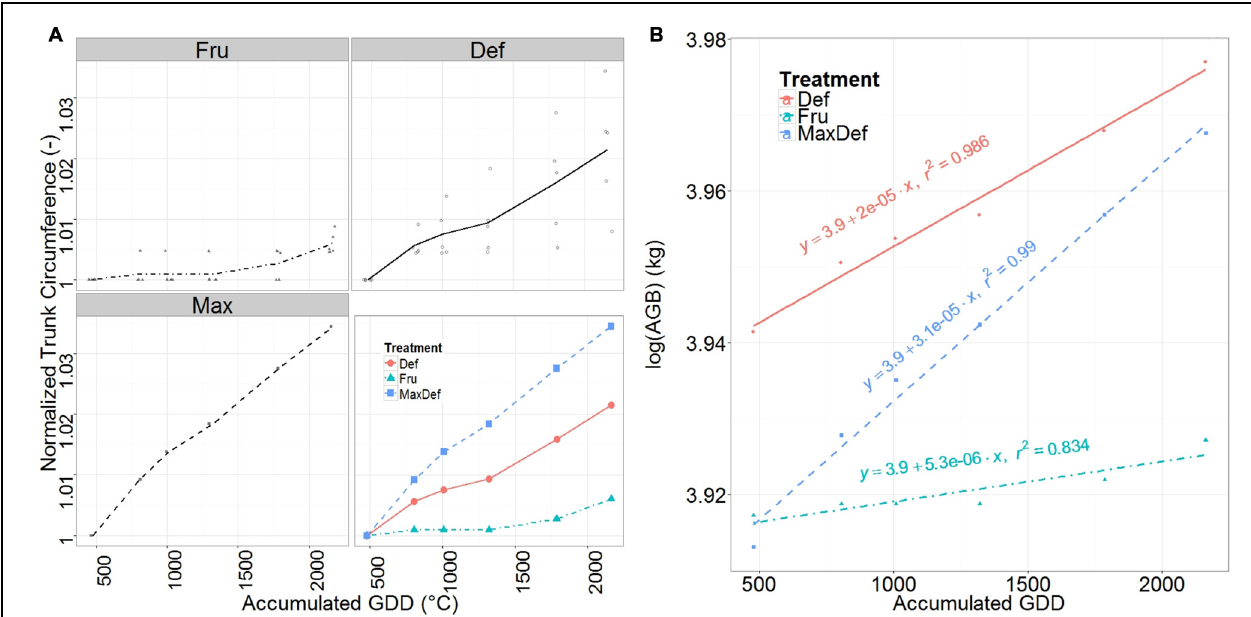
FIGURE 4 | Mean normalized trunk circumference (A) and relative growth rate (RGR) of the above ground dry woody biomass (B) for fruited (FRU) and defruited (DEF) trees, and of the Max tree, vs. the accumulated growing degree days (GDD) after bloom. Individual observations of trunk circumference are shown in the first three panels (A) . The fourth panel of (A) shows a comparison among the FRU, DEF and Max. Straight lines fitted to the natural logarithm of the total above ground woody biomass are presented in (B) . Their slopes indicate their